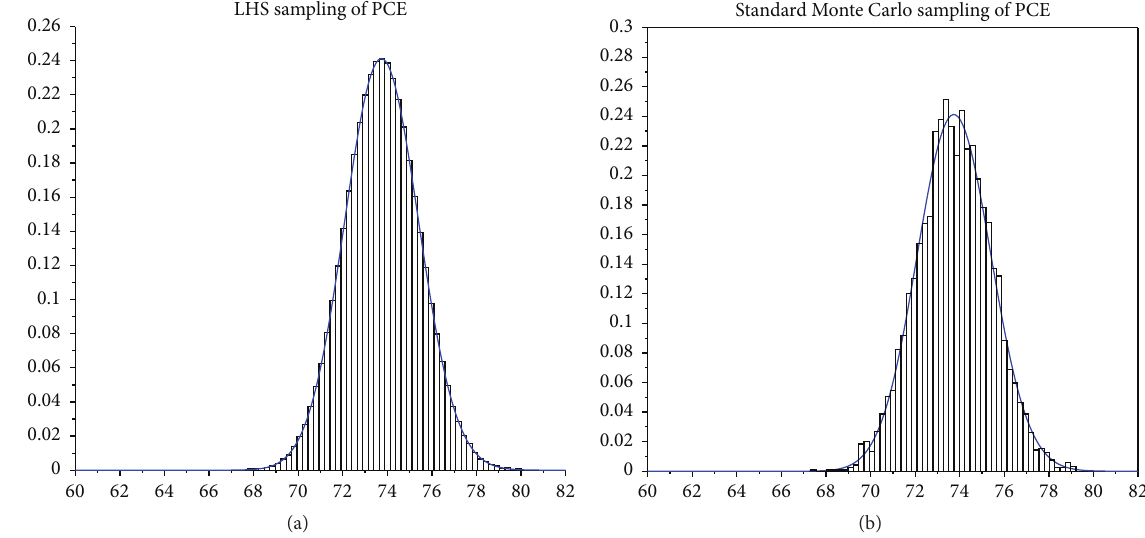
Figure 17: (a) Probability density function of CIR interest rate model, whose parameters are 𝛼 = (3/4)𝜎 2 , 𝛽 = 0.2 , 𝜎 = 0.15 , and 𝑅 0 = 110 (blue curve) and histogram of a sampling (size = 5000 ) of the 𝑅 (𝑝) 𝑇 for 𝑝 = 15 . (b) compares the analytical probability density function of CIR interest rate model, for the same parameters, with a standard Monte Carlo sampling of size 5000 of 𝑅 𝑇 at time 𝑇 = 2 .